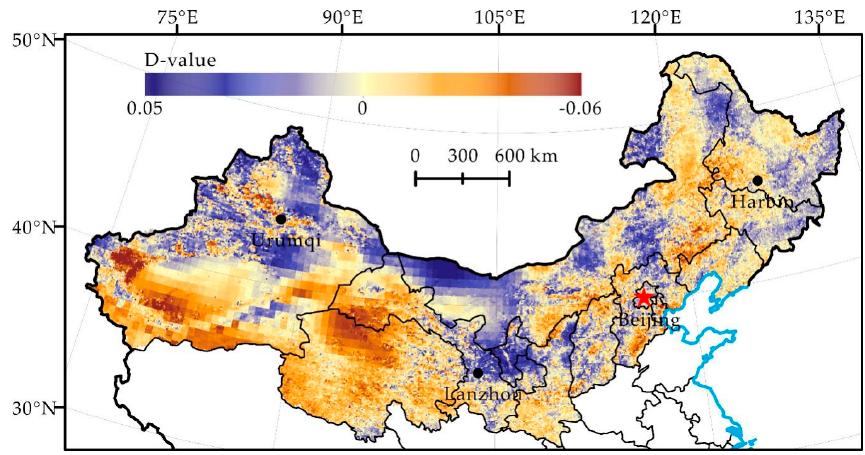
Figure 8. Distribution of Residual Trend Change from 2001 to 2012 (Where D-value positively far away from 0 is a hot spot for land degradation reversal, vice versa, land degradation development.).